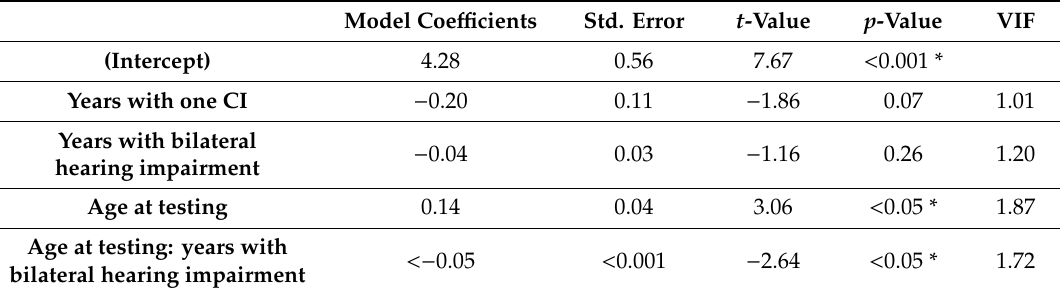
Table 4. Model coe ffi cients and p -values for the second ILD JND model. Asterisks denote the significant predictors.